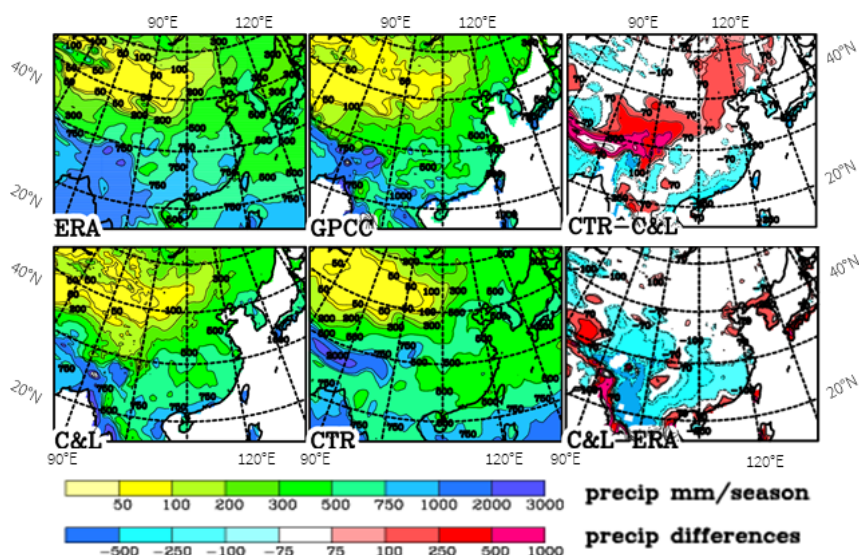
Figure 4. Summer (JJA) precipitation over eastern Asia as analysed by Leemans and Cramer (1991) (C&L), ERA-Interim and GPCC and as simulated for the present (CTR). Differences between the various fields are shown. Units: millimetres per season.